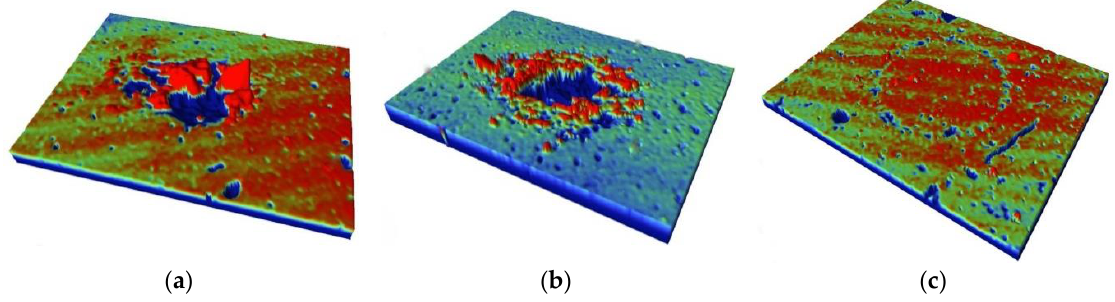
Figure 5. 3D profile of the Ti/TiN multilayer film on DU at different normal loads; ( a ) 10 N, ( b ) 20 N, ( c ) 100 N.